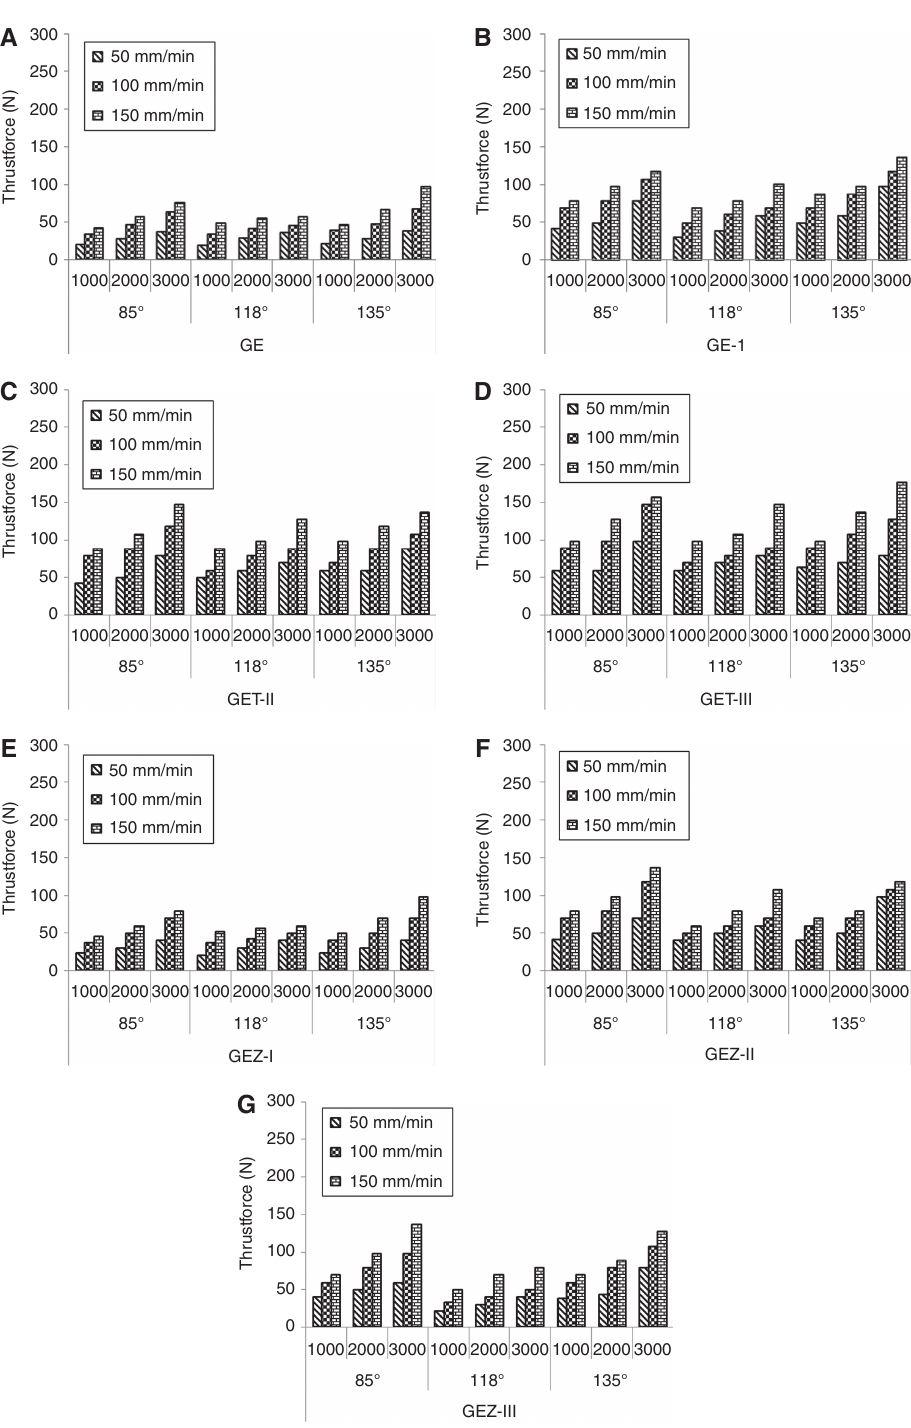
Figure 2 Comparison of thrust force against drilling speed, feed, and drill geometry for TiO